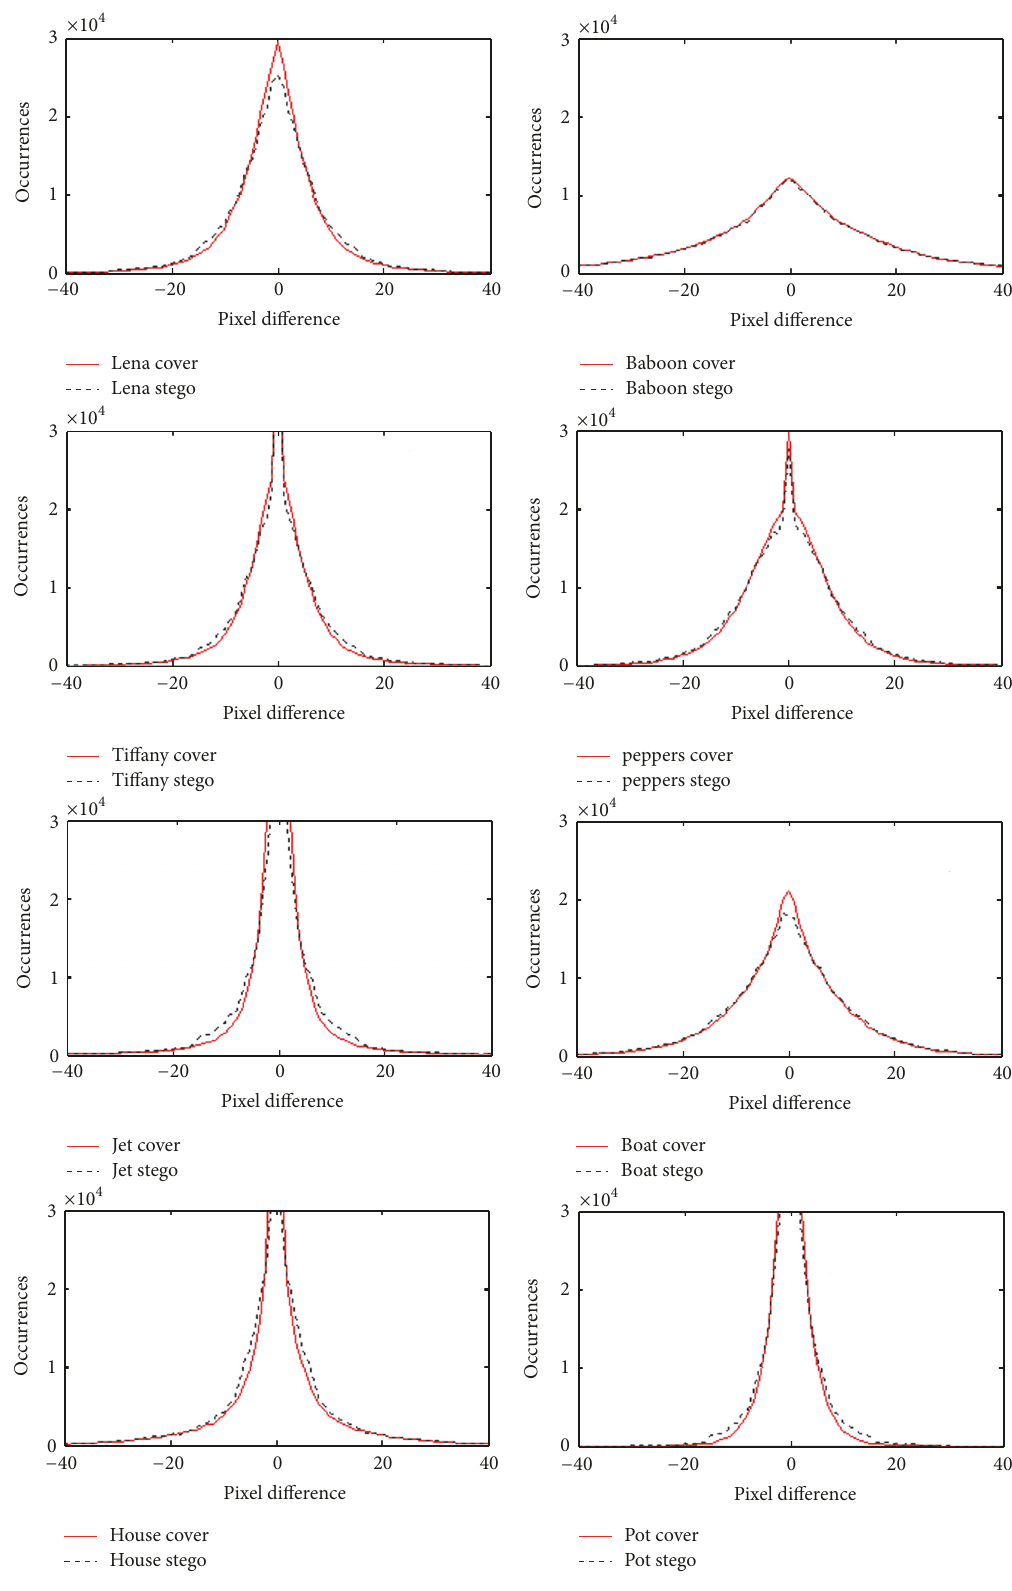
Figure 8: PDH analysis for type 2 of the proposed